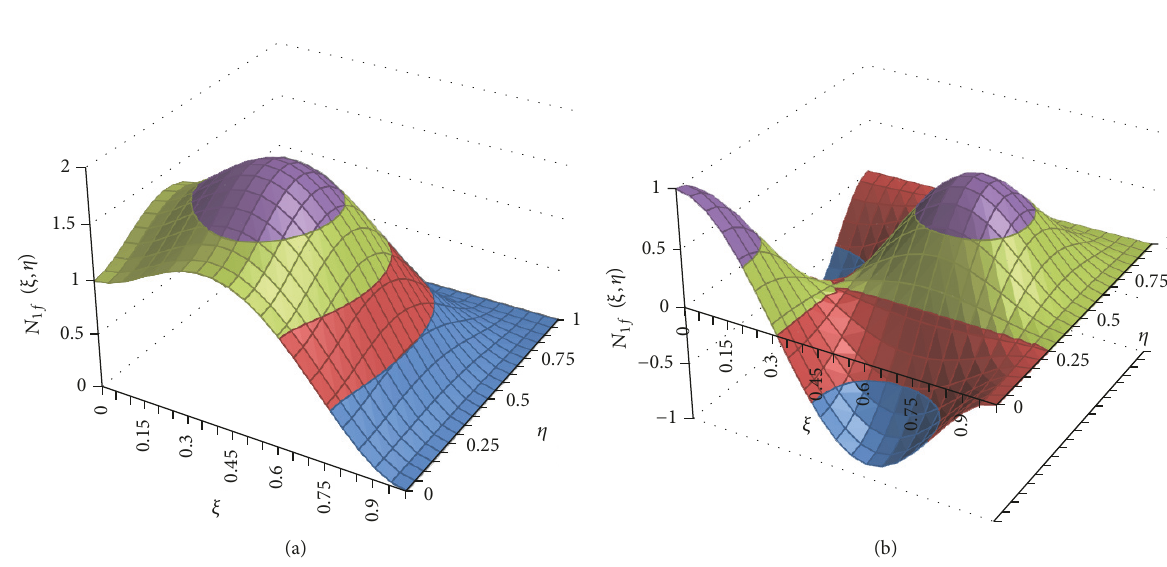
Figure 9: Shape function 𝑁 1𝑓 at 𝜔 1 (a) and 𝜔 2